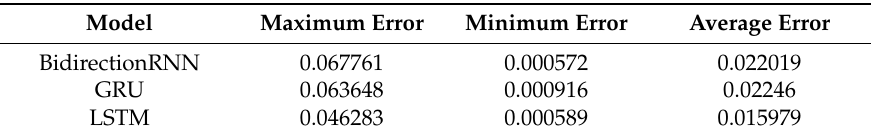
Table 5. Comparison of prediction results.